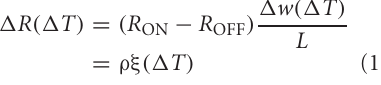
FIGURE 5 | (A) Example of memristors and CMOS neuron circuits arrangement for achieving STDP learning: feed-forward neural system with three layers of neurons and two fully connecting synapse crossbars. (B) Details of parts around one post-synaptic neuron. While a neuron is silent, it sets a constant DC voltage at its input ( V post ) and output ( V pre ) nodes. When a neuron is sending a spike, it sets a